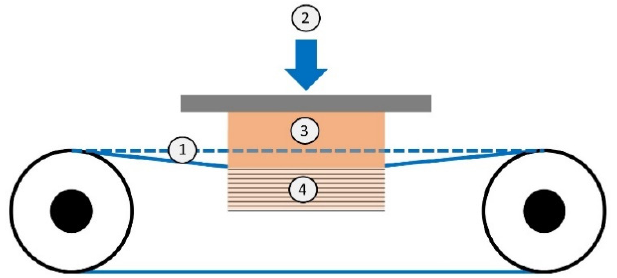
Figure 4. 1: Bow of wire web; 2: Feed direction; 3: Compact part of the workpiece; 4: Processed part of the workpiece.